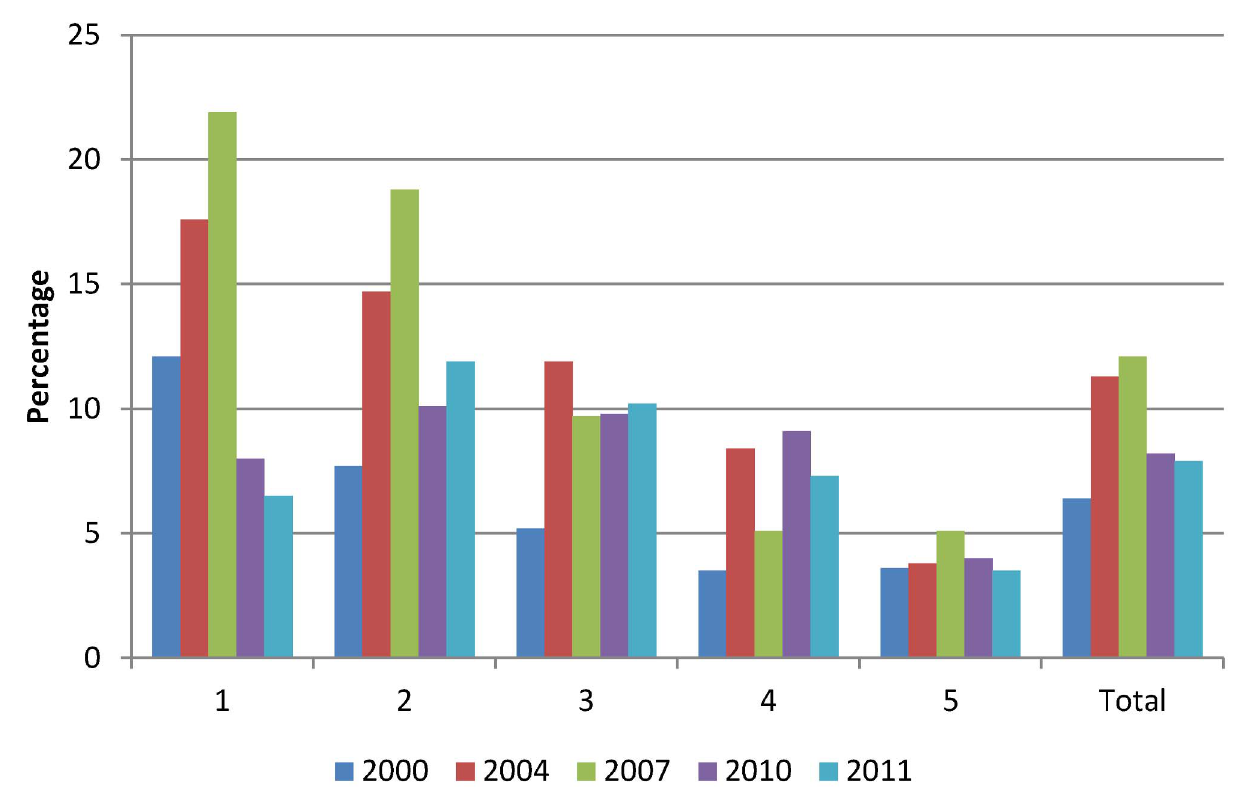
Figure 1. Out-of-pocket payments as a proportion of total household expenditure by quintiles [8].